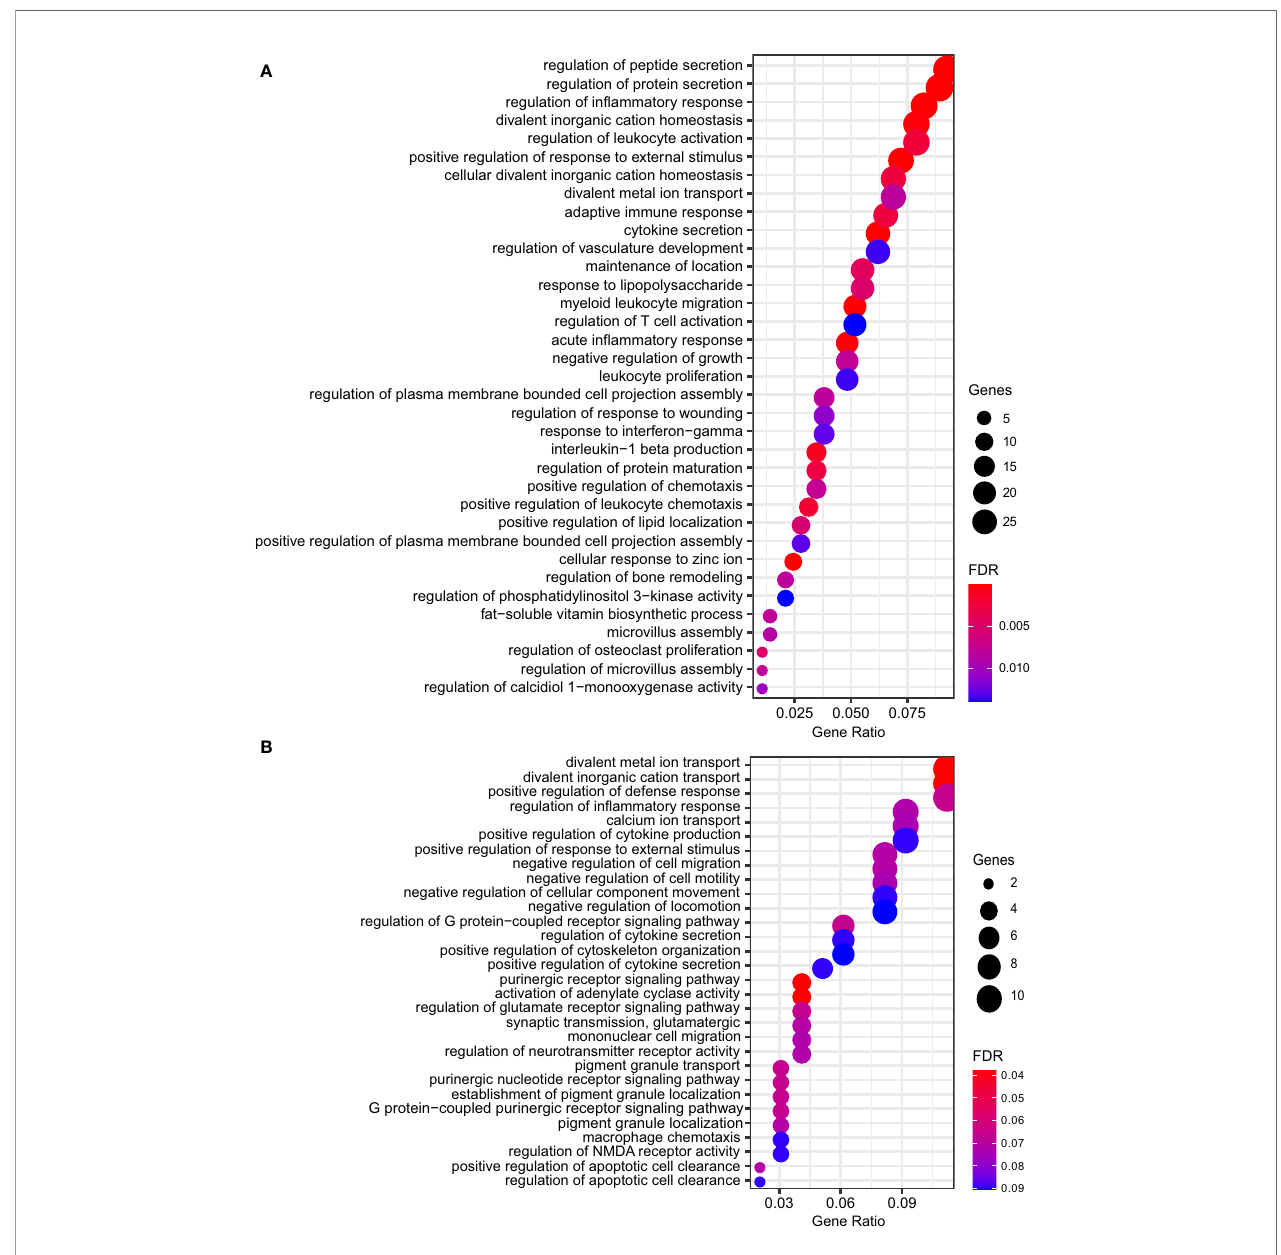
FIGURE 2 | Dot plot showing the top signi fi cant GO biological processes enriched from ORA of genes (A) upregulated (n = 35) or (B) repressed (n = 30) by M. leprae infection. Gene ratio is the fraction of genes belonging to an ontology over the total number of modulated genes. Circle size shows the number of modulated genes per biological process. FDR, false discovery